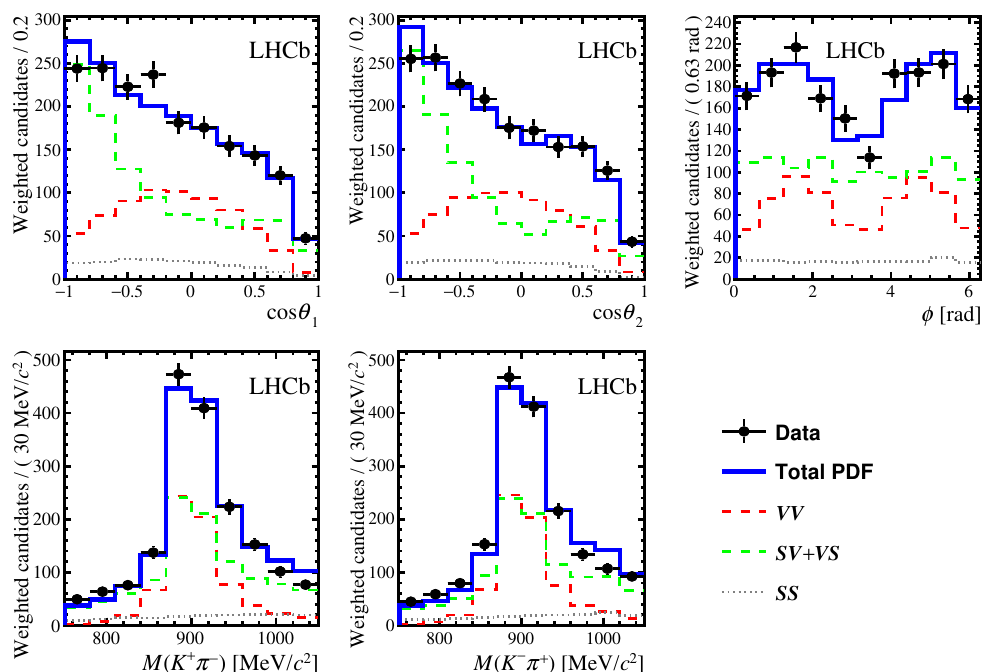
Figure 5 . Projections of the amplitude (cid:12)t results for the B 0 K (cid:3) 0 K (cid:3) 0 decay mode on the helicity s ! angles (top row: cos (cid:18) 1 left, cos (cid:18) 2 centre and (cid:30) right) and on the two-body invariant masses (bottom row: M ( K + (cid:25) (cid:0) ) left and M ( K (cid:0) (cid:25) + ) centre). The contributing partial waves: V V (dashed red), V S (dashed green) and SS (dotted grey) are shown with lines. The black points correspond to data and the overall (cid:12)t is represented by the blue line.